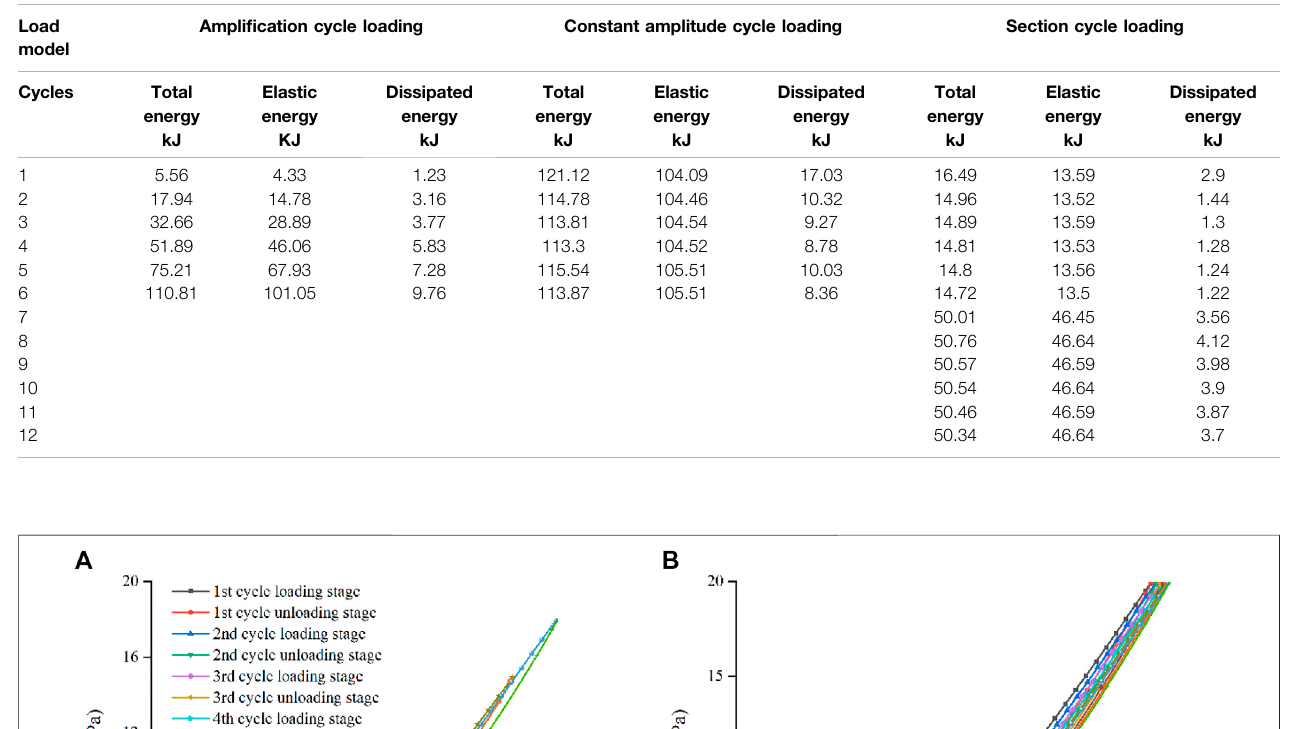
TABLE 2 | Calculation results for each cycle energy for different loading modes.